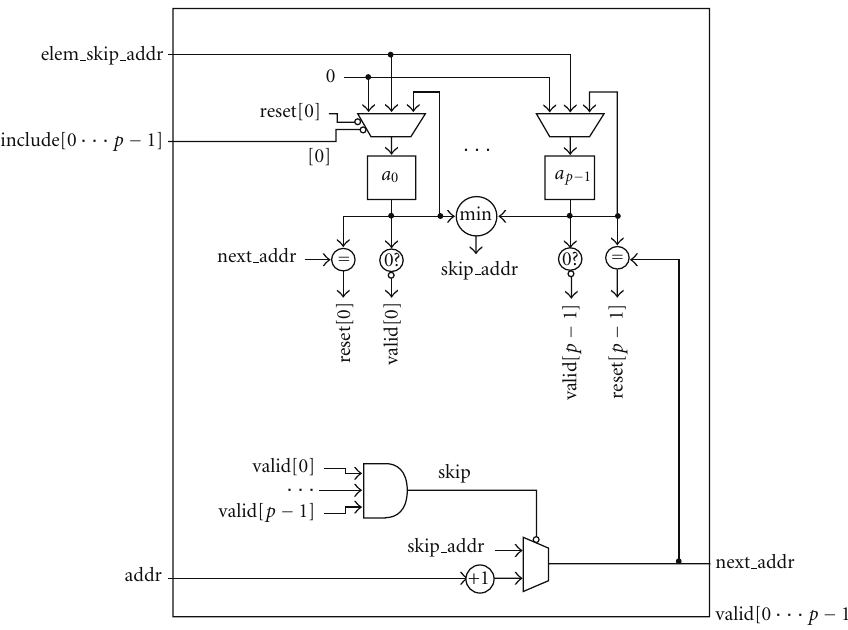
Figure 5: Simplified traversal generator logic for preorder tree traversal used to implement Barnes-Hut. The traversal generator guides exploration of the data structure for p simultaneous traversals, minimizing accesses by coordinating multiple datapaths by selectively asserting valid[ ] using membership data from each datapath’s generator kernel on include[ ]